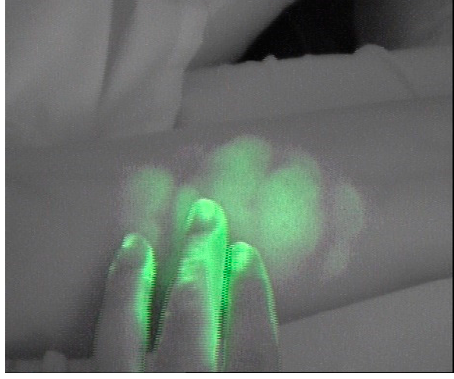
Figure 1. Contamination of the patient and physiotherapist skin with ICG.